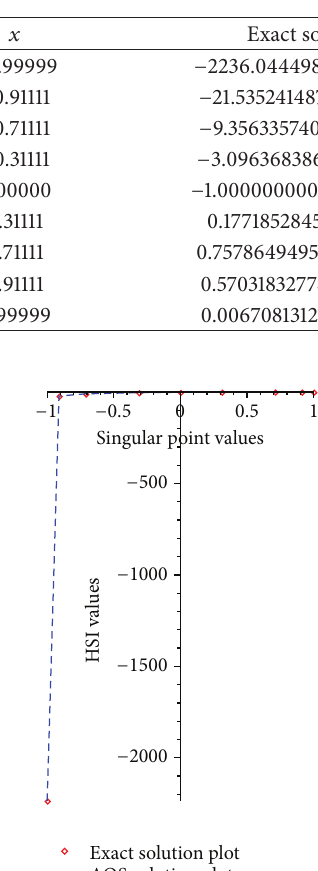
Table 1: Results of HSIs for 𝑤 1 (𝑡) .